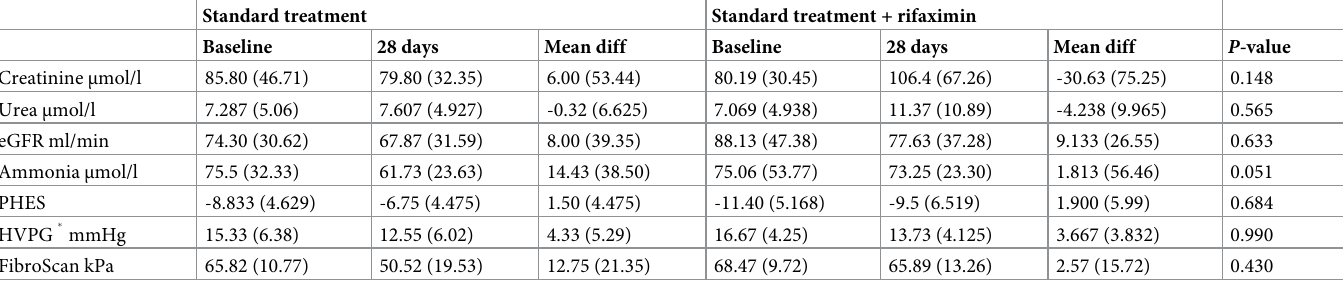
Eight patients in the SMT group and seven patients in the SMT + rifaximin group had com- parable measures of inflammation markers after 90 days. The remaining nine patients in the SMT group and eight patients in the SMT + rifaximin group had amino acids analysed after 90 days. No significant differences between the levels of amino acids at baseline and after 90 days were found in either group (S1 Table). The secondary outcomes of liver function and kidney function (Creatinine and Urea) were also found to be unaffected by rifaximin (Table 4). Table 4. Secondary outcomes of liver function. Standard